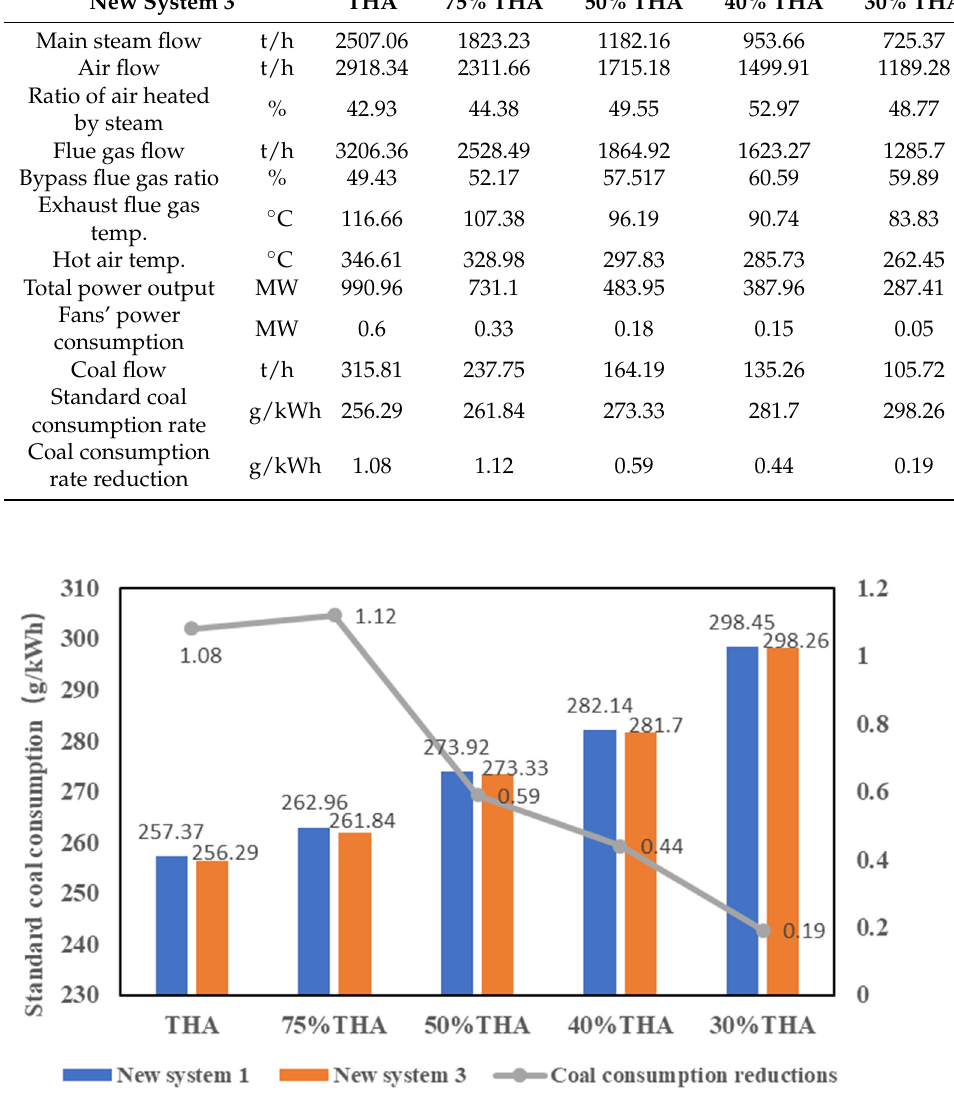
Figure 16. The standard coal consumption comparison of three systems under variable conditions.